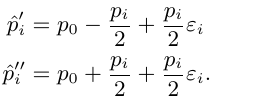
Figure 2: Merge operation from